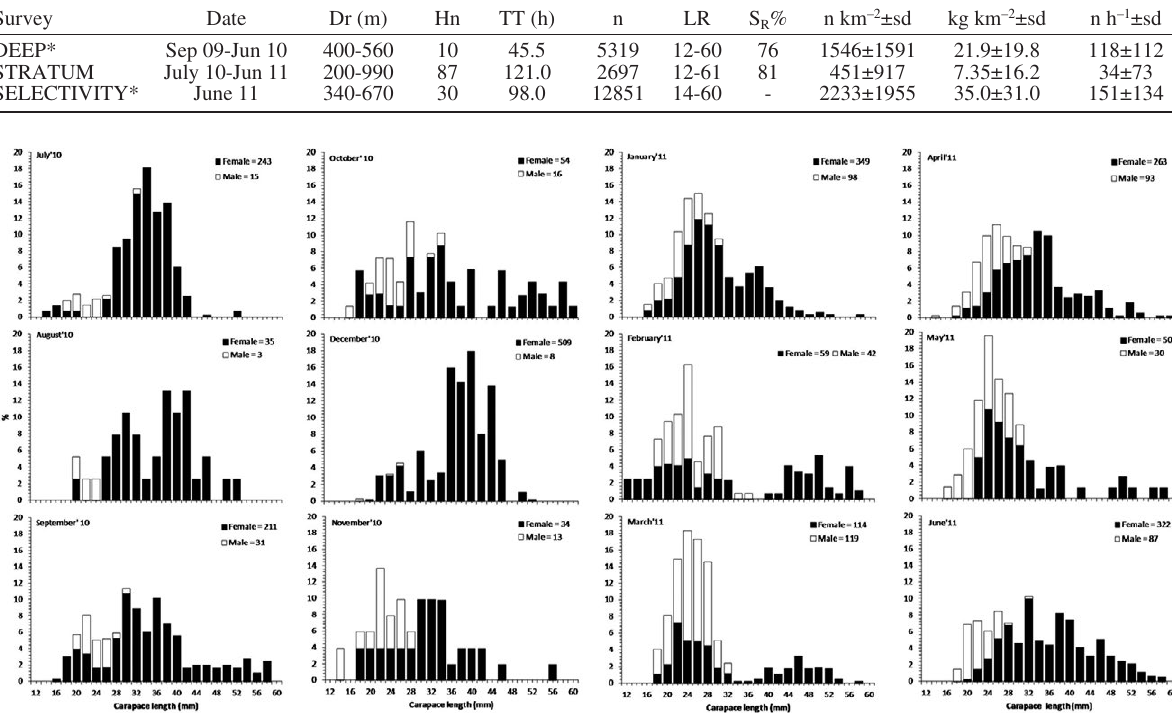
Fig. 2. – Monthly length-frequency standardized distributions by sex of A. antennatus caught during the STRATUM survey. Closed squares, females; open squares,